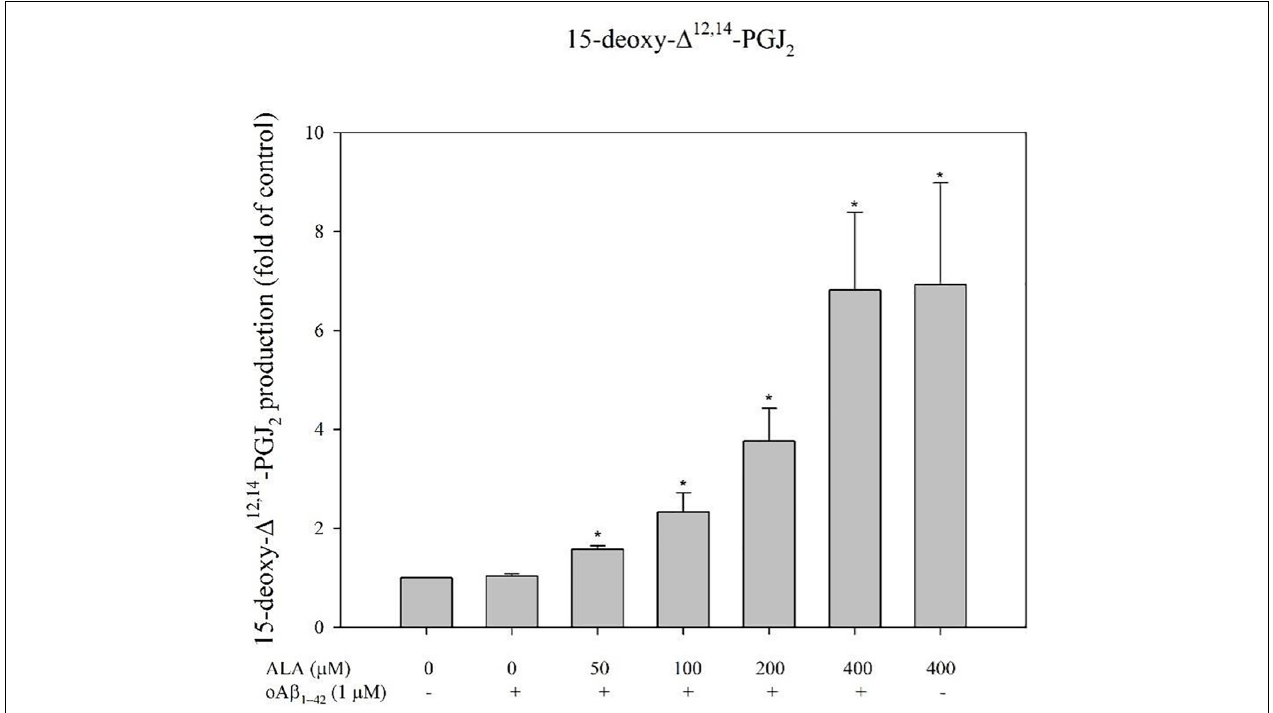
FIGURE 8 | Alpha-lipoic acid promoted 15-deoxy- (cid:49) 12 , 14 -PGJ2 production in BV-2 mouse microglial cells. BV-2 cells were pretreated with or without different concentrations of ALA for 30 min, followed by vehicle or oA β 1 − 42 treatment for 24 h. Relative 15-deoxy- (cid:49) 12 , 14 -PGJ2 production was detected using ELISA. Data are presented as means ± SDs. * p < 0.05 vs. the vehicle control